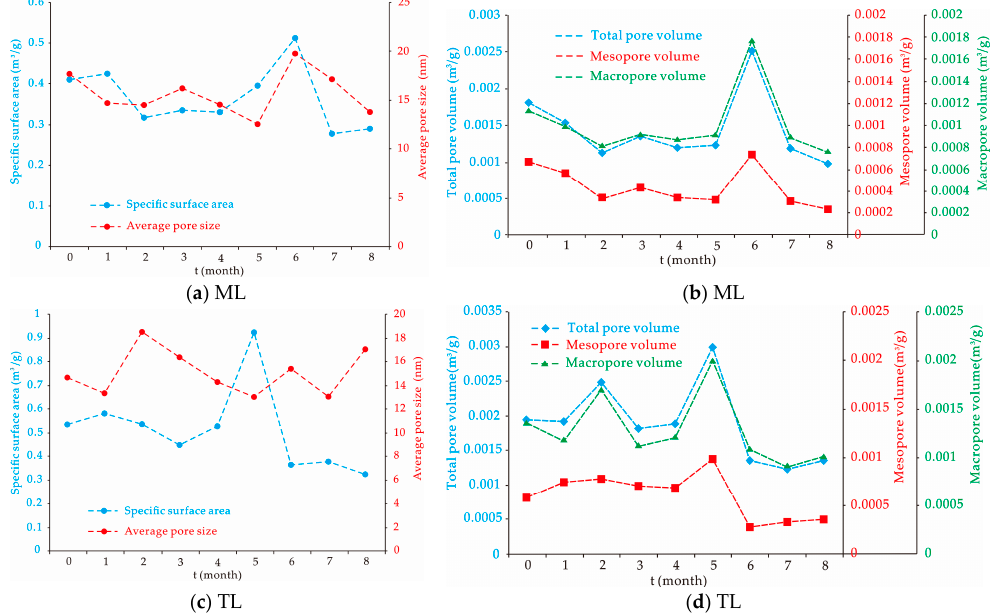
Figure 7. Dynamic of specific surface area ( a , c ) and pore volume ( b , d ) over time. ML represents Malan samples and TL represents Tunlan samples. Specific surface area was calculated through the BET method. Mesopore volume was calculated using the BJH method.